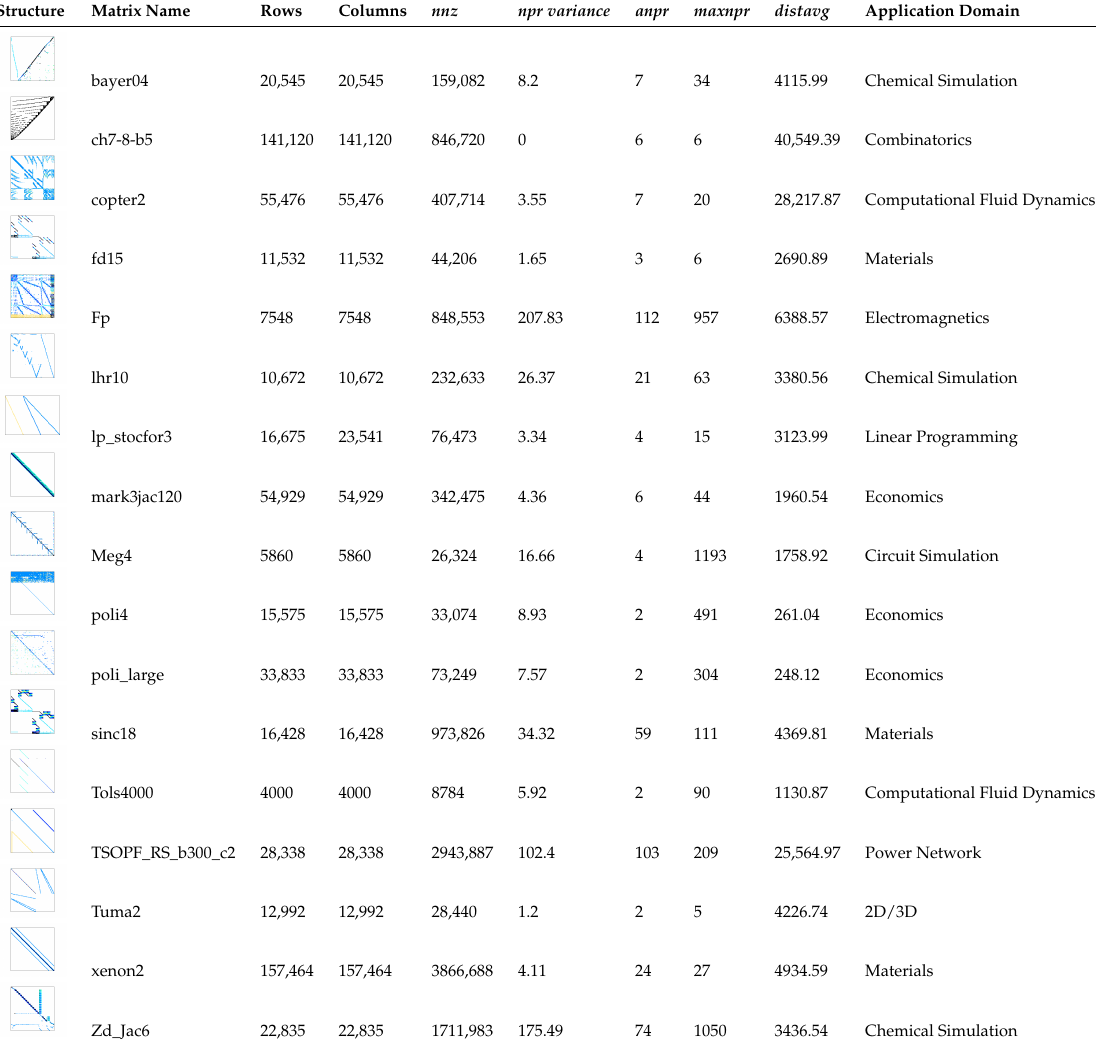
Table 1. Benchmark dataset of sparse